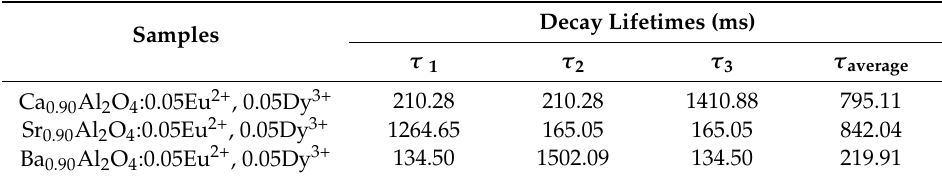
Table 2. Results for fitted decay curve of Ca 0.90 − x Al 2 O 4 :0.05Eu 2+ , 0.05Dy 3+ , Sr 0.90 − x Al 2 O 4 :0.05Eu 2+